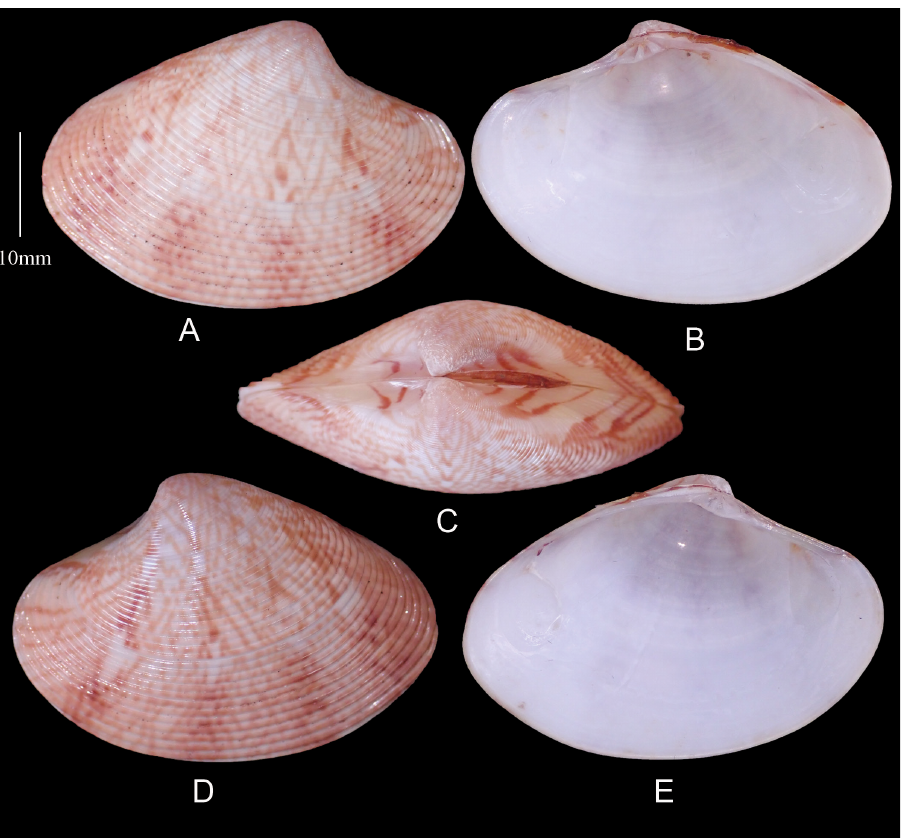
Original combination. Venus ziczac Linnaeus, 1758 Synonyms. (from MolluscaBase 2018d) Venus sinuosa Lamarck, 1818; Tapes inflata Römer, 1870 Type locality. Linnaeus (1758) gives the type locality as the Indian Ocean. Material examined. Neendakara, Kollam, 5 live collected specimens + 18 empty articulated shells; Dharmadam, Kannur, 3 live collected specimens. Description. Shells to 50 mm, solid, inflated, equivalve, inequilateral, beaks slightly in front of midline. Outline sub-ovate, lunule margin impressed, anterior mar- gin pronounced, posterior ventral margin subtruncate, posterior area strongly sinu- ous. Lunule lanceolate, weakly ridged. Escutcheon narrow, smooth. Sculpture of raised concentric ridges separated by nearly equal-sized grooves. Pallial sinus narrow, apex